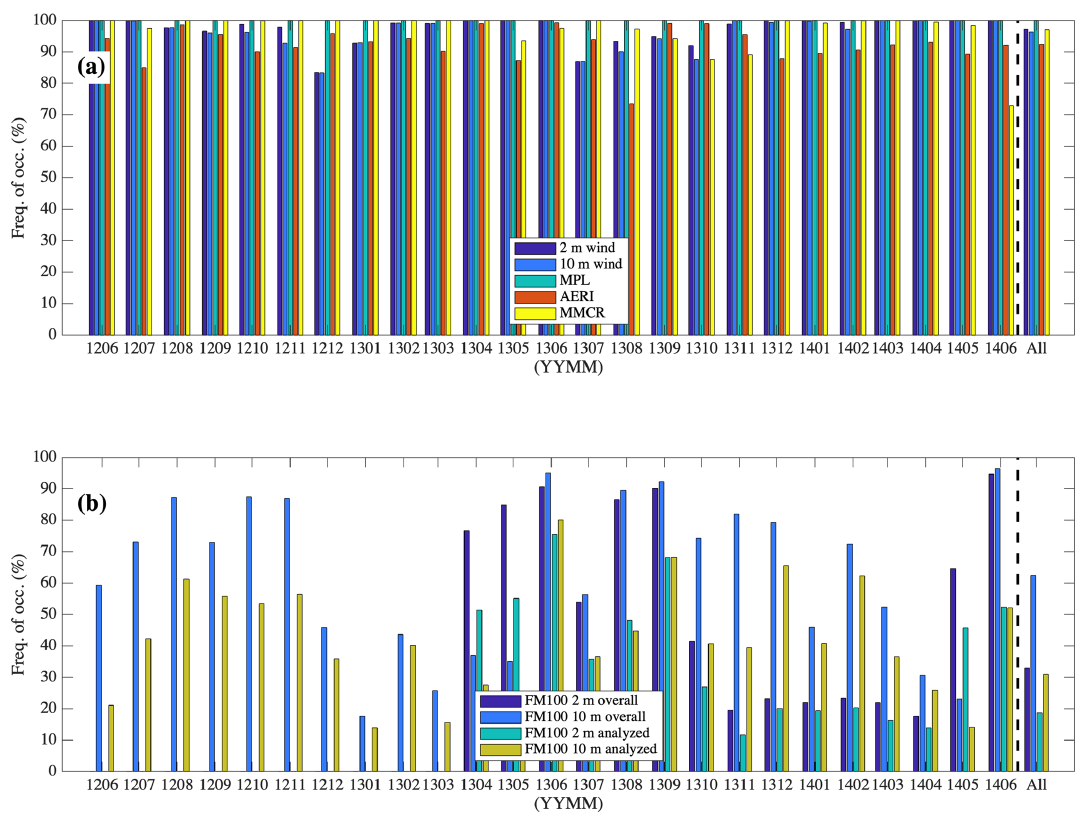
Figure 2. (a) Percent of available data: wind (blues), MPL (green), AERI (red), and MMCR (yellow) for each month in the study period. (b) Similar to panel (a) but for the FM100s at 2m (dark blue and green) and 10m (light blue and yellow). Blues show the amount of available data while yellow and green show the amount of analyzed data after screening for wind direction and availability of ancillary measurements from panel (a)